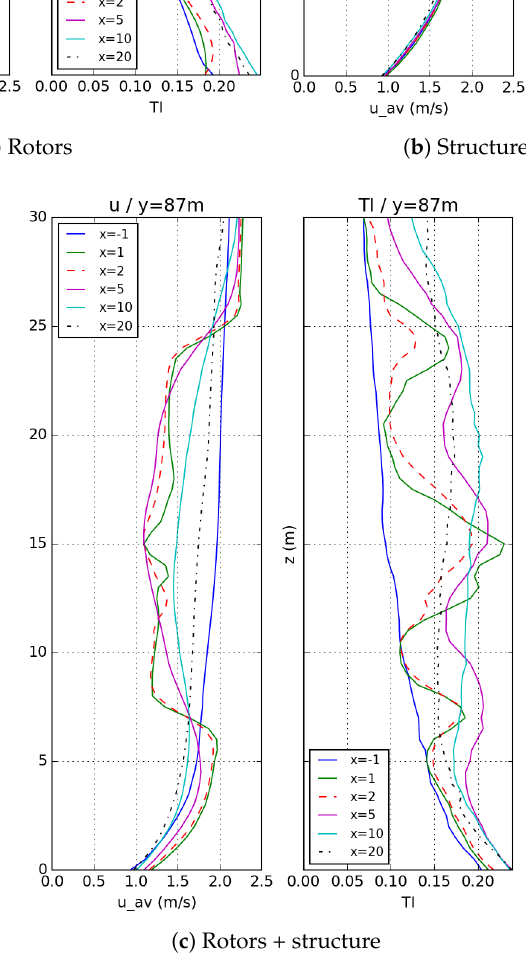
Figure 13. Vertical profiles of time-averaged velocity magnitude and turbulence intensity for rotors, structure and rotors with structure. The units for x are D, i.e., the rotor diameter (=16